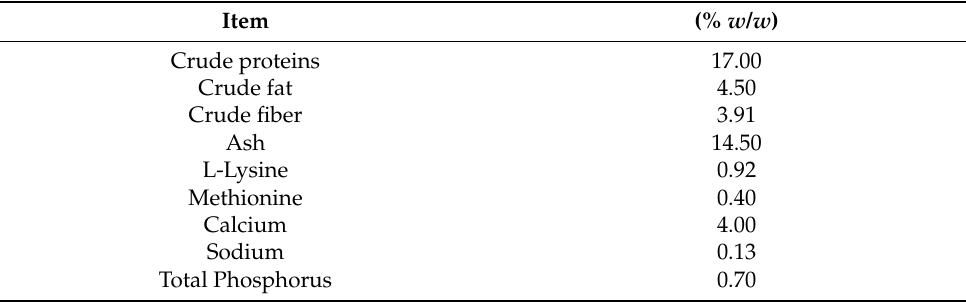
Table 1. Main nutritional components of hen basal